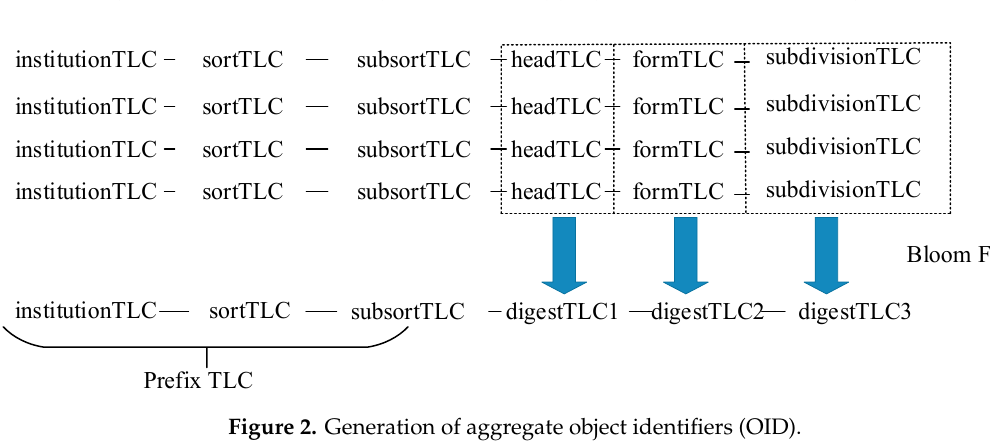
Figure 3. The format of digest type ‐ length ‐ content (TLC).